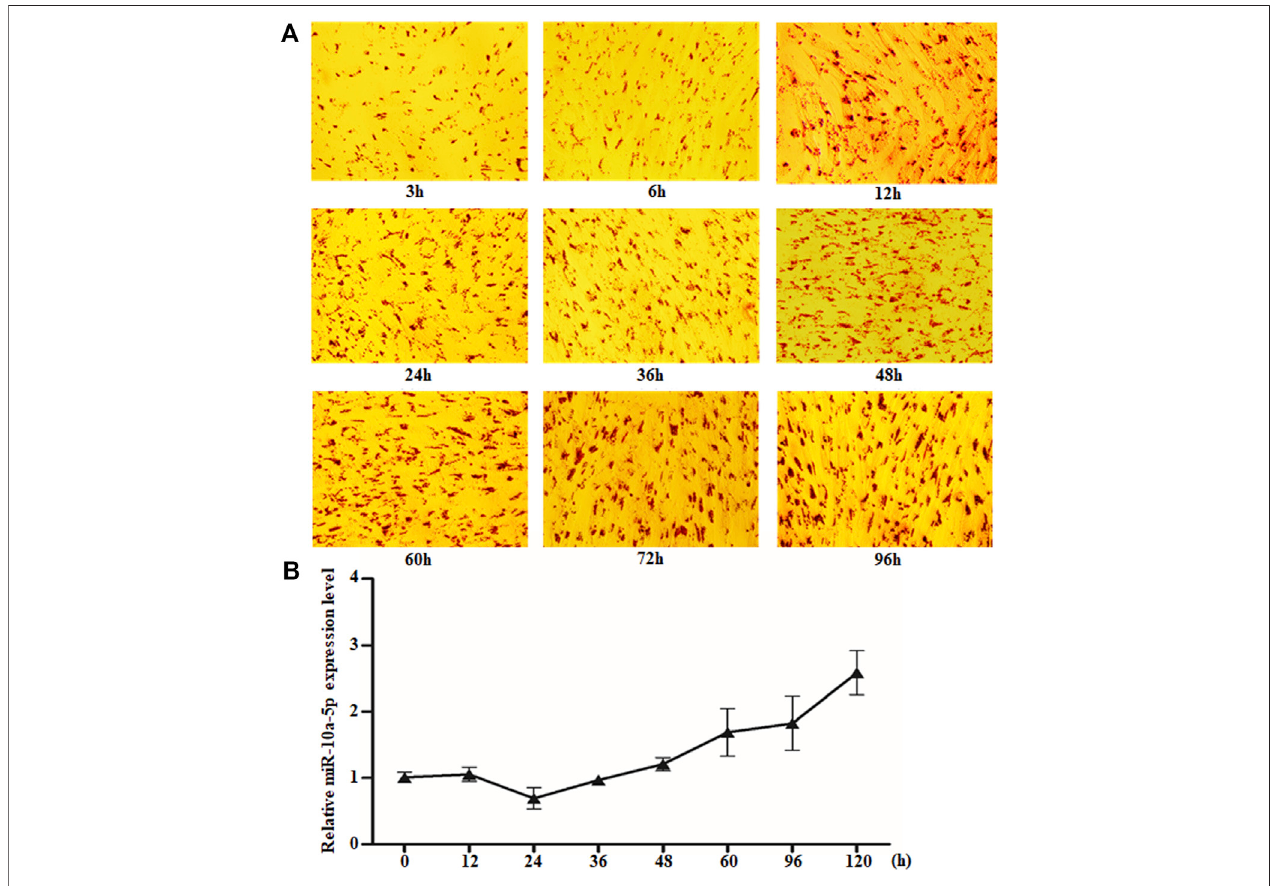
FIGURE 1 | miR-10a-5p expression changed obviously during GIPC differentiation. (A) Representative images of Oil O staining of GIPCs cultured in oleic acid induction medium for different hours. (B) qRT-PCR analysis of the relative level of miR-10a-5p expression in GIPCs cultured in oleic acid induction medium for the hours as indicated. N > or (cid:1) 3 for A and